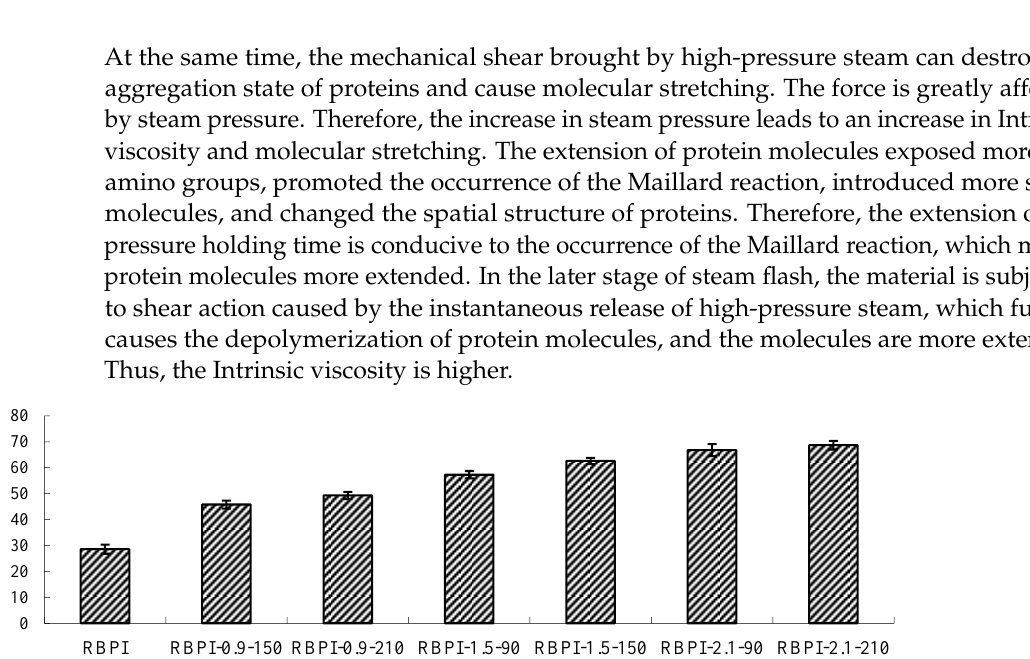
Table 1. Thermal transition characteristics of rice bran protein isolate.